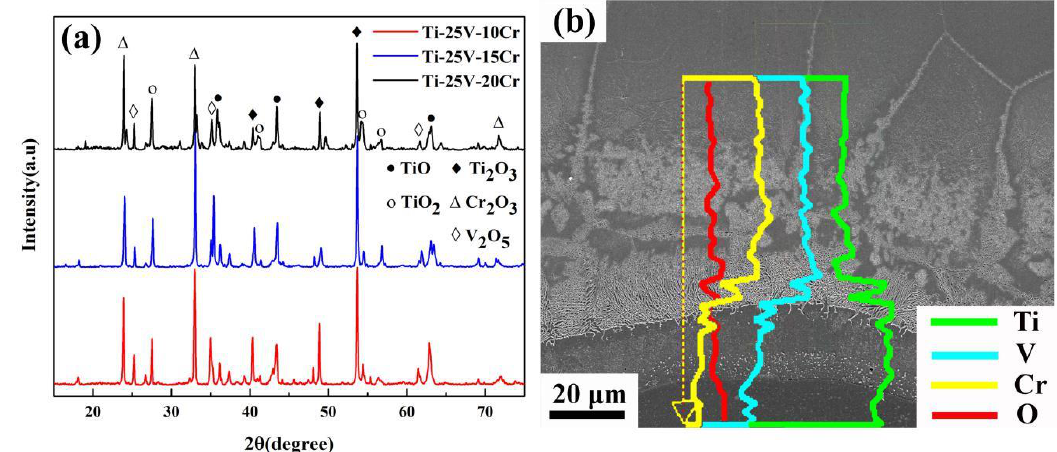
Figure 5. ( a ) XRD analysis results of Ti-Cr-V alloys after combustion, ( b ) line scanning curves of EDS analysis across the melting zone and oxide zone.